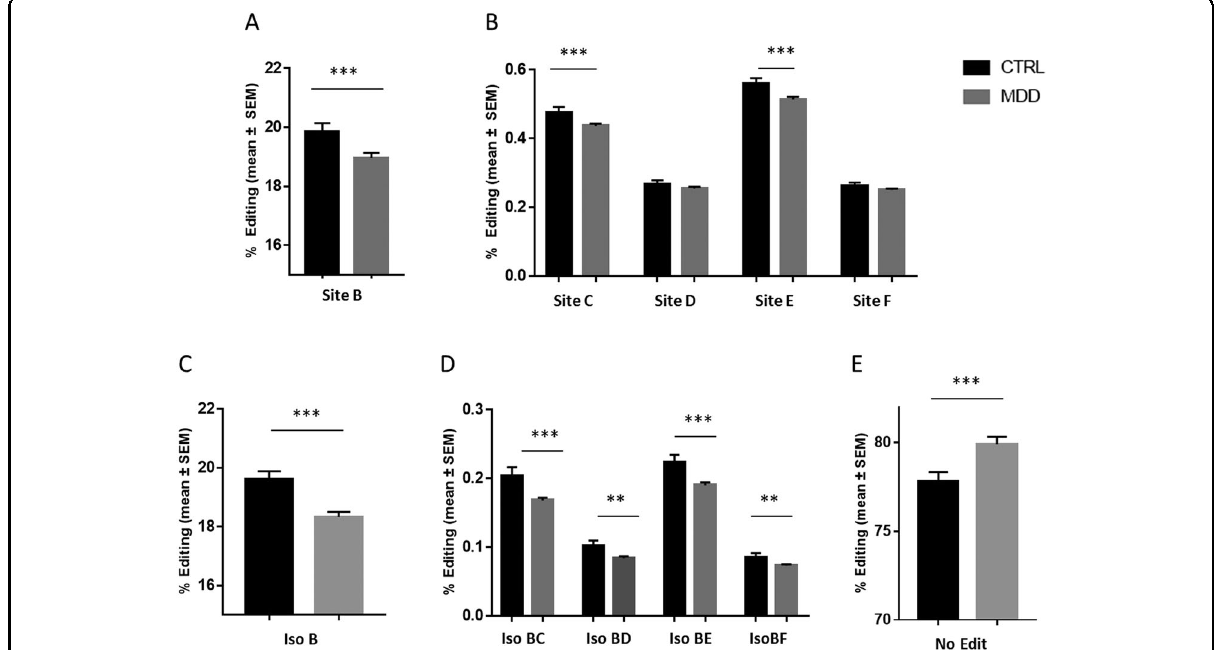
Fig. 2 Relative proportion of mRNA PDE8A editing sites and isoforms measured in controls and depressed (MDD) patients. Histograms represent relative editing proportion (%) of the detected PDE8A editing site ( A , B ) or isoform ( C – E ) in healthy controls (mean± s.e.m.; n = 99) or in the MDD group ( n = 158). Only isoforms representing more than 0.1% of relative proportion were included in the analysis. Black: Controls, dark grey: MDD. The symbol * indicates a p -value ≤ 0.05, ** p -value ≤ 0.01, and *** p -value ≤